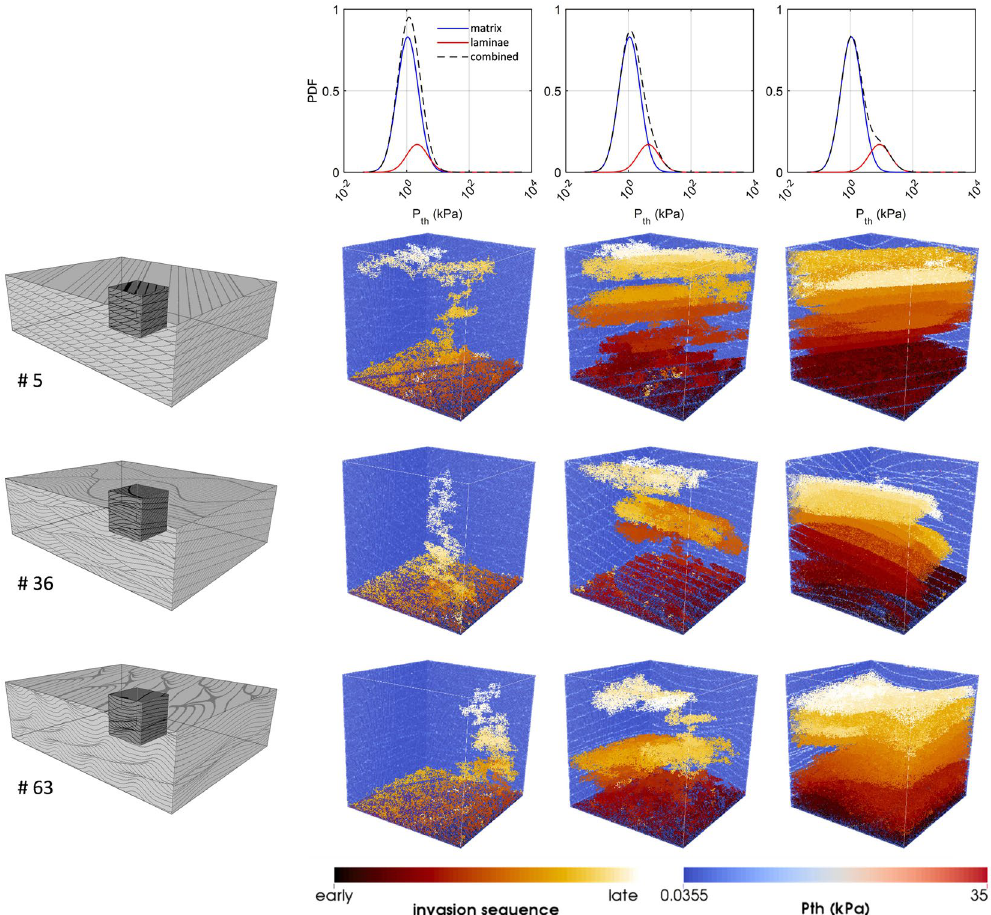
Figure 3. Invasion percolation simulations of CO 2 migrating through cubic sub-volumes derived from BAMs #5, #36, and #63 (grayscale models on leftmost column) and populated with P th values generated using three different textural contrasts. The three bimodal distributions (top row) are created by assigning constant P th PDF to matrix (in this case Moderately Sorted Upper Coarse Sand, or MUCSa, in blue) and changing P th PDF of laminae (in this case showing Upper Medium Sand > Upper Fine Sand > Upper Very Fine Sand, from low to high P th , in red). Color background of cubic models represents range of threshold capillary pressures (see Fig. 4C). A continuous planar source of CO 2 was placed at the bottom boundary of the model domain. The increasing textural contrast leads to different responses in terms of displacement patterns and plume trapping as can be observed from invasion sequences of CO 2 .